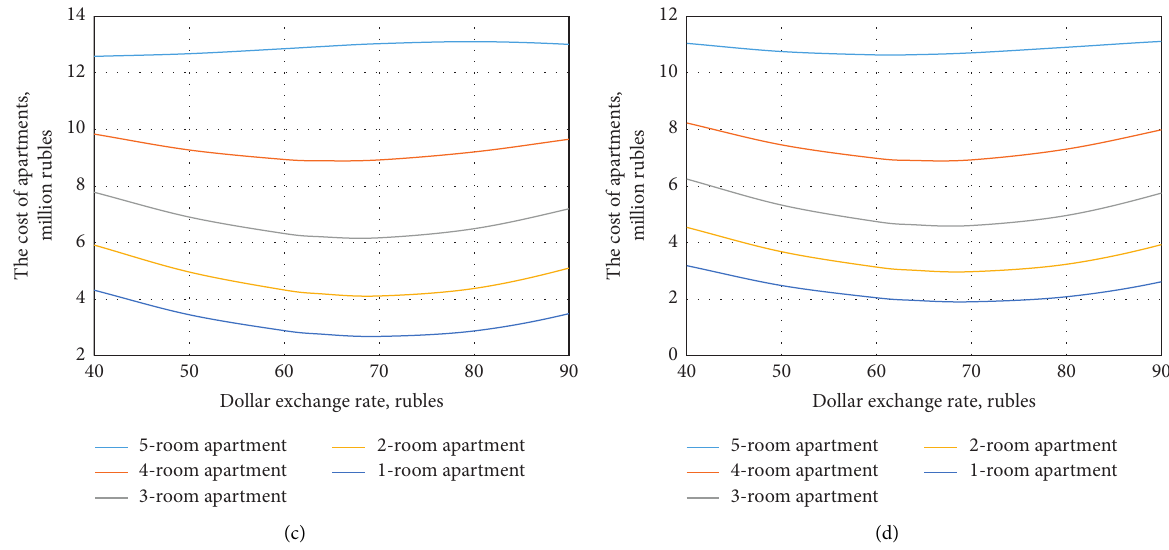
Figure 10: Scenario forecast of the dependence of apartment costs in Russian cities on the exchange rate of the US dollar against the Russian rubble. (a) Moscow, (b) Saint Petersburg, (c) Yekaterinburg, and (d)